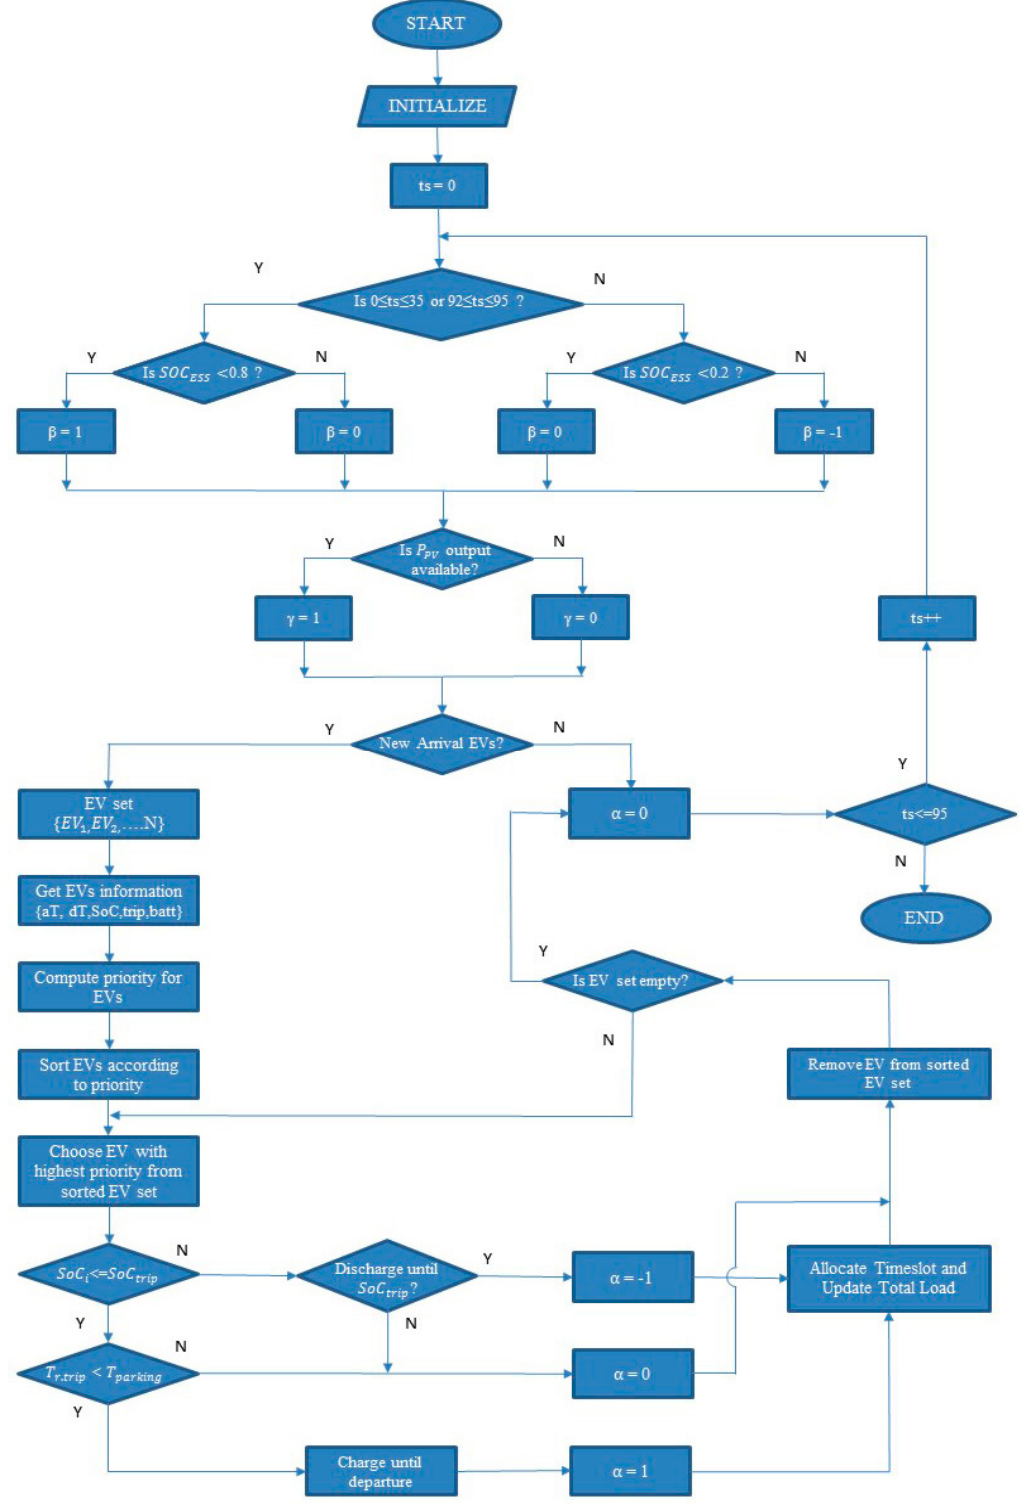
Figure 5. Flowchart of main algorithm.